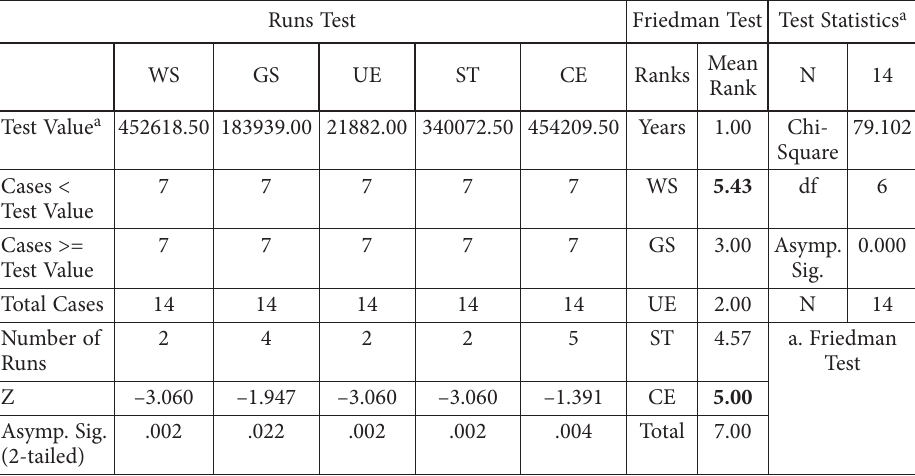
Table 8. Runs and Friedman